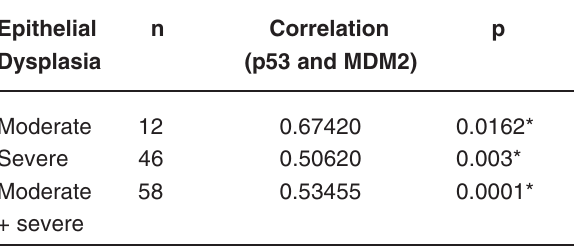
*Significant level at 5%. Spearman